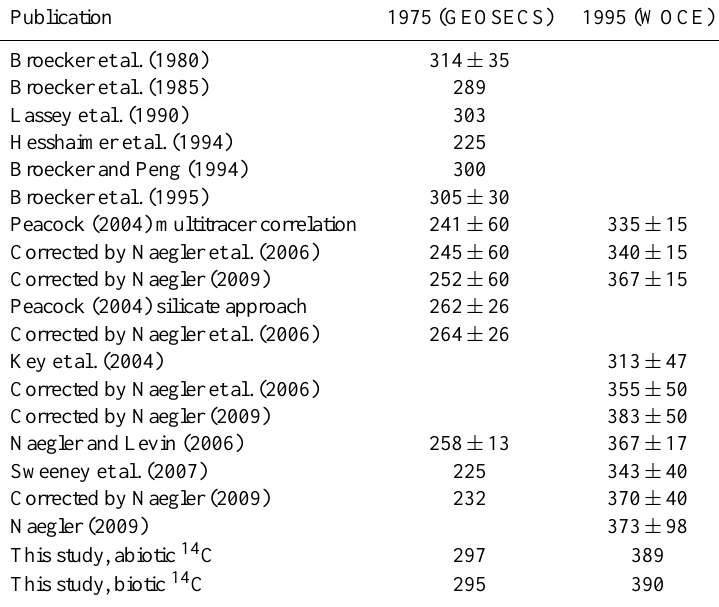
Table 2. Excess oceanic radiocarbon inventory, measured in 10 26 atoms of 14 C, from various sources for 1975 (GEOSECS) and 1995 (WOCE). Corrections by Naegler et al. (2006) are for neglected ocean regions; corrections by Naegler (2009) are for neglected contributions from increasing DIC. The values from this study are listed at the bottom, for the abiotic and biotic implementation. The biotic excess radiocarbon inventories are the same for all biological fractionation choices